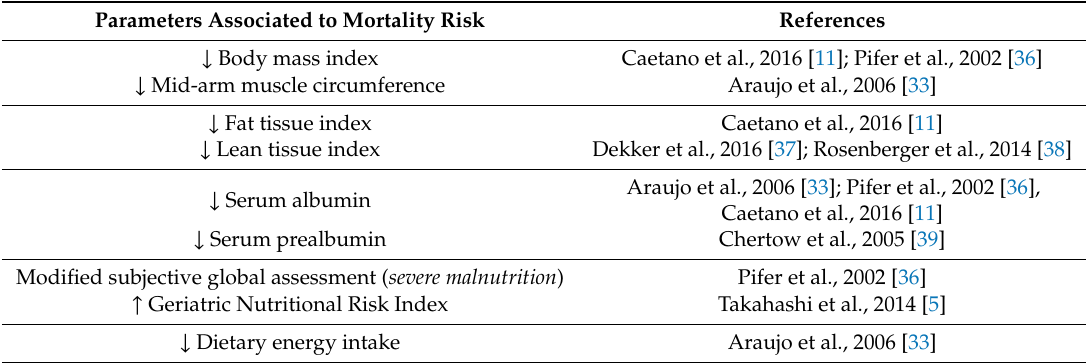
Table 2. Mortality risk in maintenance HD patients according to nutritional indicators of